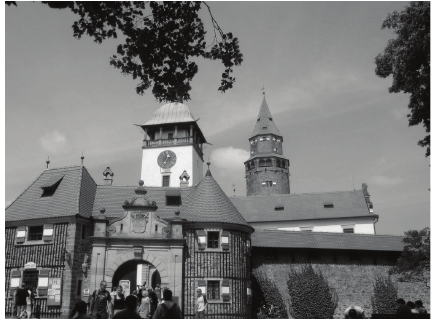
Figure 10: Table—the ESA fusion of the image “Castle,” 4 input images, approximate run time: 18 sec.